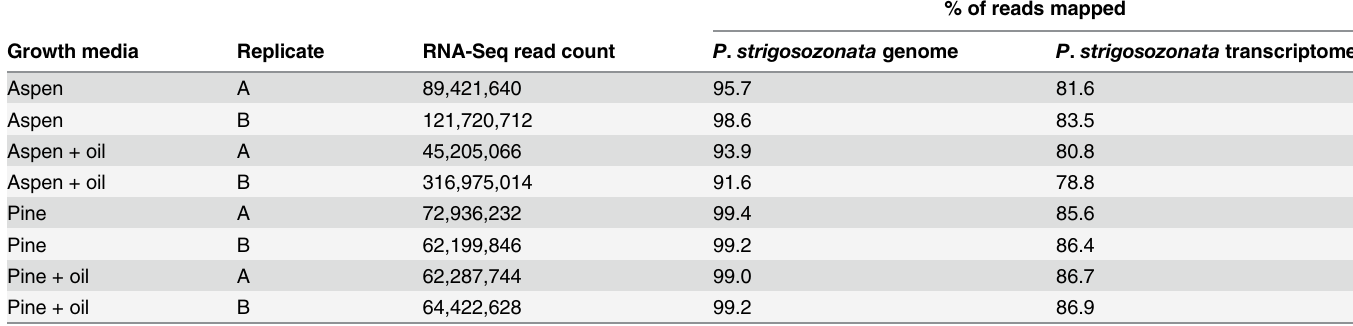
(Table 2). Information about RNA purity and concentration is presented in S1 Table. Principal components analysis and Pearson correlations revealed that mapped RNA-Seq reads in Table 2. Illumina RNA-Seq read counts and percentages of reads mapped to the Punctularia strigosozonata genome and transcriptome. % of reads mapped Growth